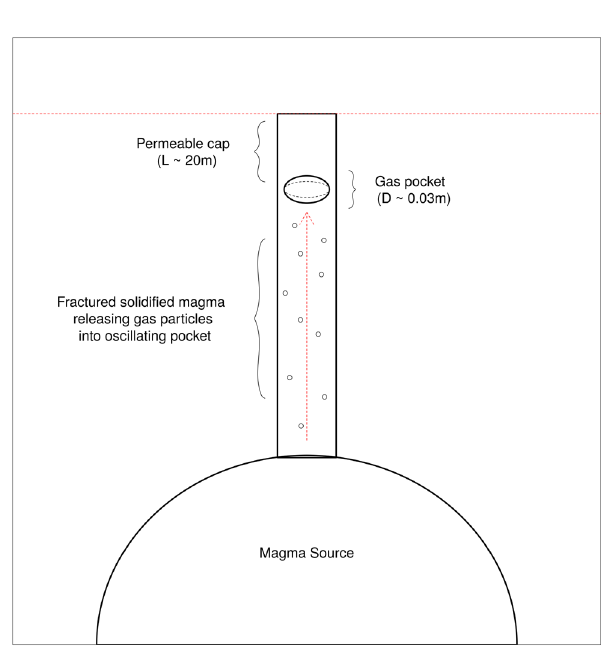
Figure 4: Simplified diagram illustrating the geome- try and mechanism for the oscillating gas pocket model [Girona et al. 2019]. Geometric variables include the initial pocket thickness D and the cap thickness L . Fig- ure adapted from Figure 1 in Girona et al.